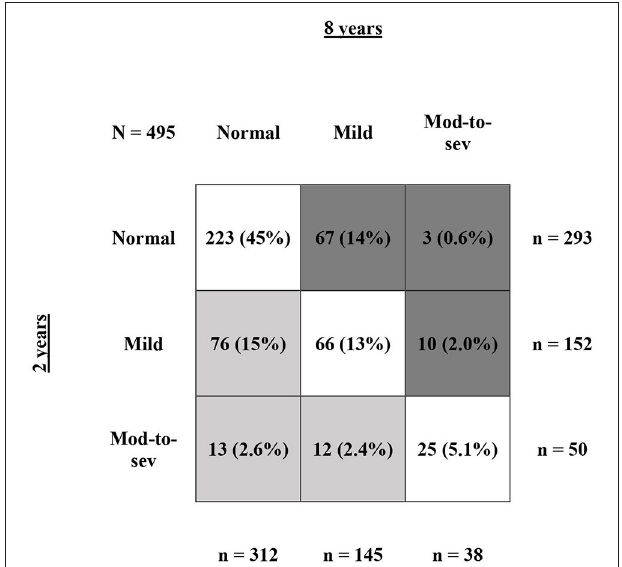
FIGURE 2 | Shifts in NDI from 2 to 8 years of age. This figure shows NDI rate at 2 vs. 8 years of age for infants with NDI calculation at all three follow-up contacts ( N = 495). The numbers are presented as N (%), with the % calculated relatively to the full group of N = 495 infants. The row sums show the total number of infants at 2 years of age for normal, mild, and moderate-to-severe NDI. The column sums show the total number of infants at 8 years of age for normal, mild, and moderate-to-severe NDI. The dark gray boxes represent all infants that deteriorated toward a worse NDI category from 2 to 8 years, the light gray boxed represent all infants that improved toward a better NDI category from 2 to 8 years, and the white boxes represent all infants that remained in the same NDI category.